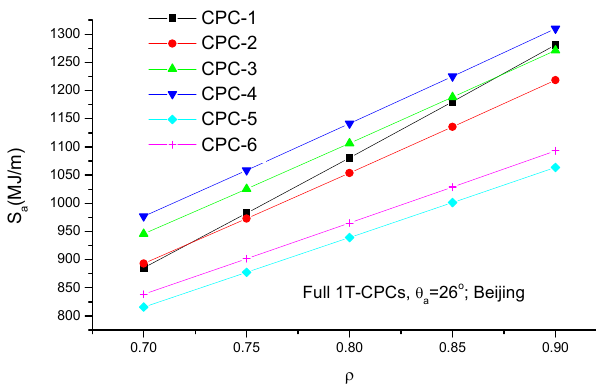
Figure 10. Effects of reflectivity on the annual collectible radiation on EST of full 1T ‐ CPCs.